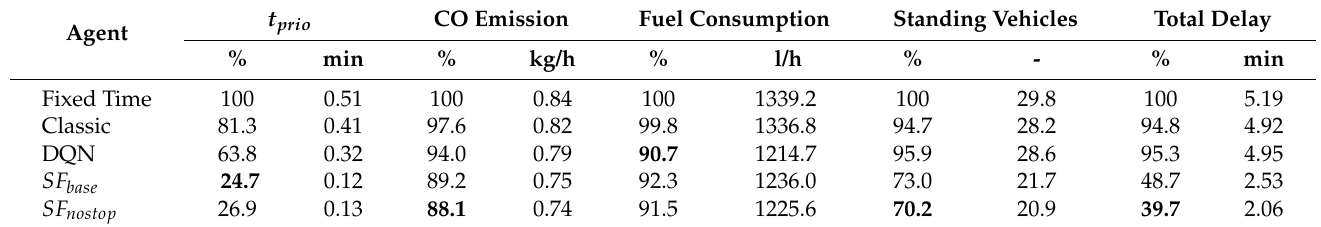
Table 2. Comparison of the performance between the different solutions in case of uniform